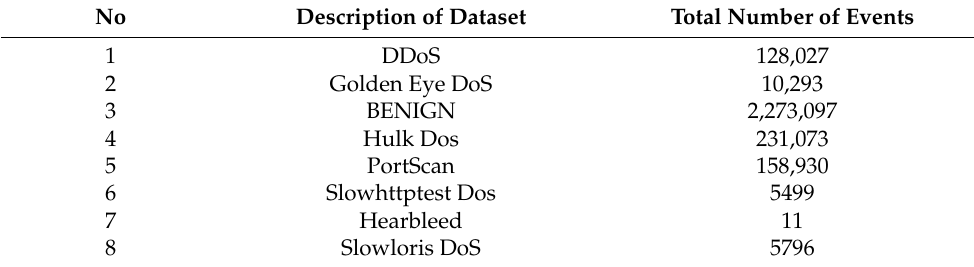
Table 3. CIC-DoS 2017